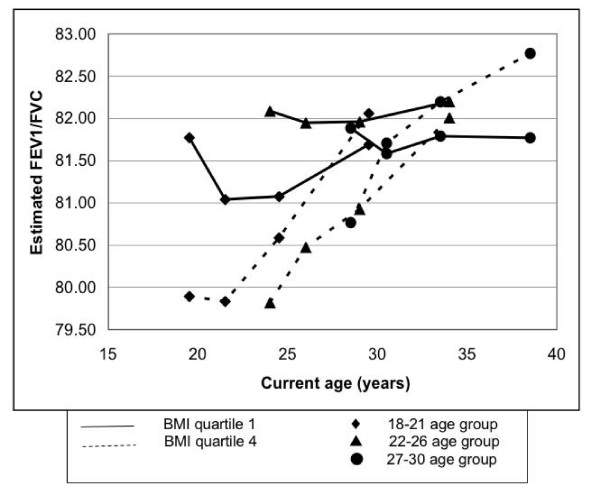
FEV1/FVC in year 0 BMI quartiles across three birth cohorts: 18–21 years, 22–26 years, and 27–30 years at baseline, based on repeated measures linear regression analysis and adjusted for race, sex, current age, smoking status at year 0, asthma status, time, physical activity score at year 0, and alcohol consumption at year 0. The slope of FEV1/FVC across time becomes increasingly positive with increasing year 0 BMI (p trend < 0.0001).